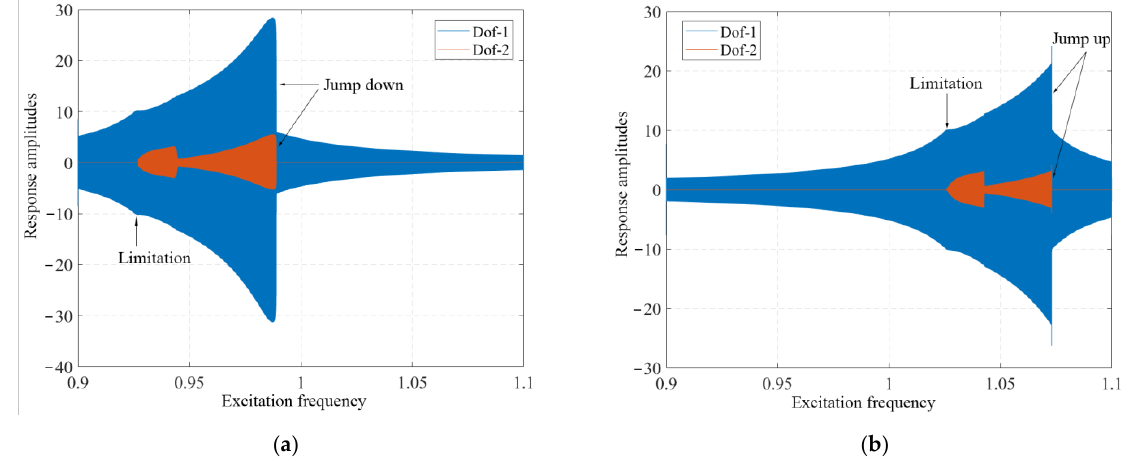
Figure 14. Continuous sweep response of the system at the excitation frequency of 0.9 – 1.1: ( a ) fre- quency increase (speed-up); ( b ) frequency decrease (coast down). ( a ) frequency increase (speed-up); ( b ) frequency decrease (coast down).